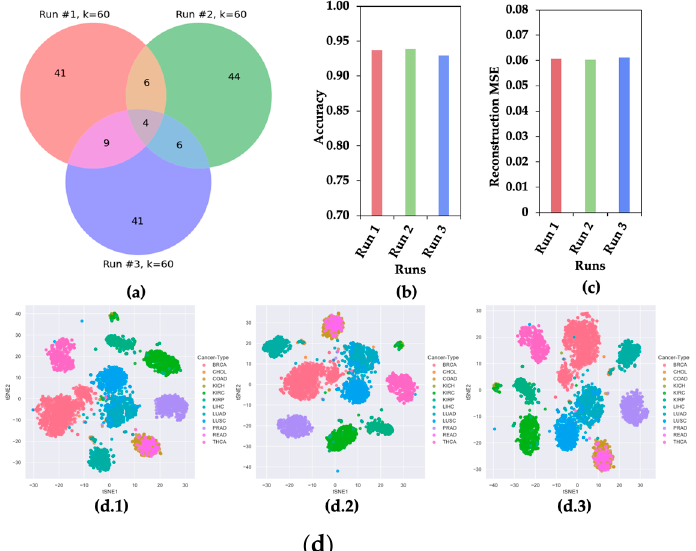
Figure 2. CAE Property of Selecting Different Sets of Features in Different Runs. ( a ) Venn Dia- gram, ( b ) accuracy of classifying 12 cancer types, ( c ) reconstruction mean squared error (MSE), and ( d ) t-SNE plots for 12 cancer samples using three sets of 60 features selected in three runs.